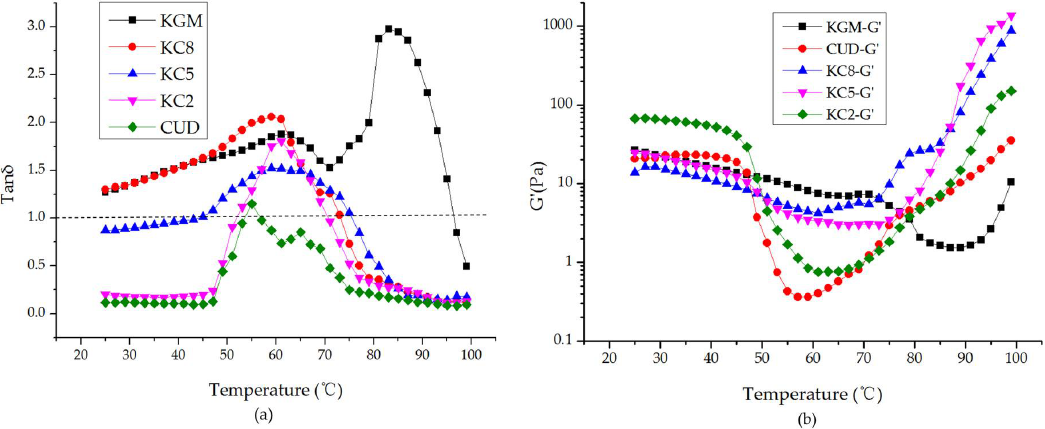
Figure 5. Curves showing the variation in ( a ) tanδ and ( b ) G’ for the KGM/CUD blend system with the increasing of temperature during the heating process. increasing of temperature during the heating